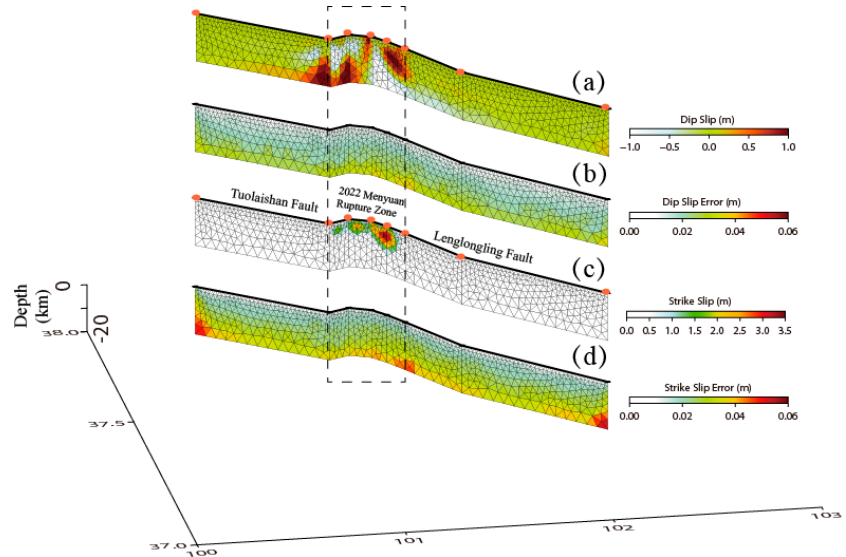
Figure 9. Coseismic slip distribution of the 2022 Menyuan earthquake. ( a ) Dip-slip component, in which red (positive) values indicate upward motion and white (negative) values indicate downward motion. ( b ) Errors in the dip-slip component. ( c ) Left-lateral strike-slip component. ( d ) Error for the strike-slip component.